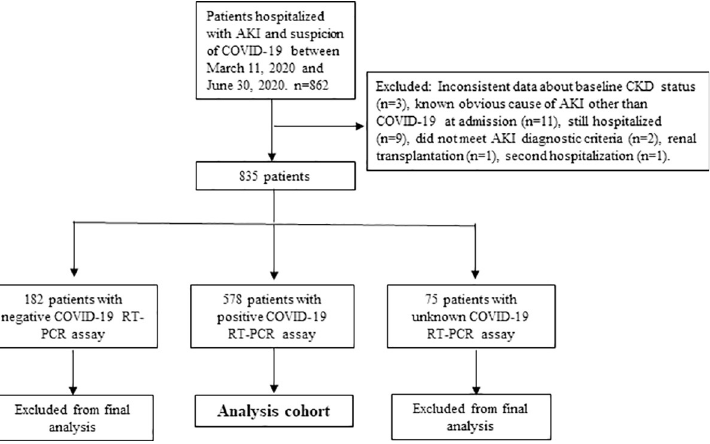
Fig 1. Flowchart of patient selection for the study. The diagram shows the numbers of individuals ( n ) excluded at different stages and the identification of cases for the analysis.